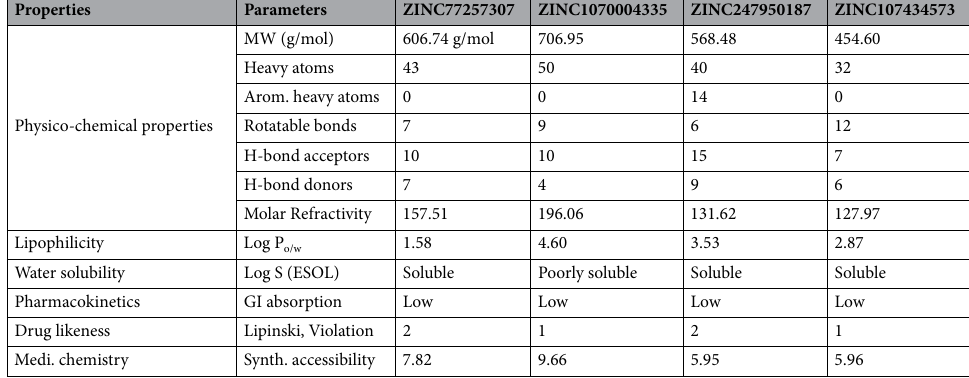
Table 4. List of pharmacokinetic properties (physico-chemical, lipophilicity, water solubility, drug likeness, and medicinal chemistry) of the selected 4 compounds.